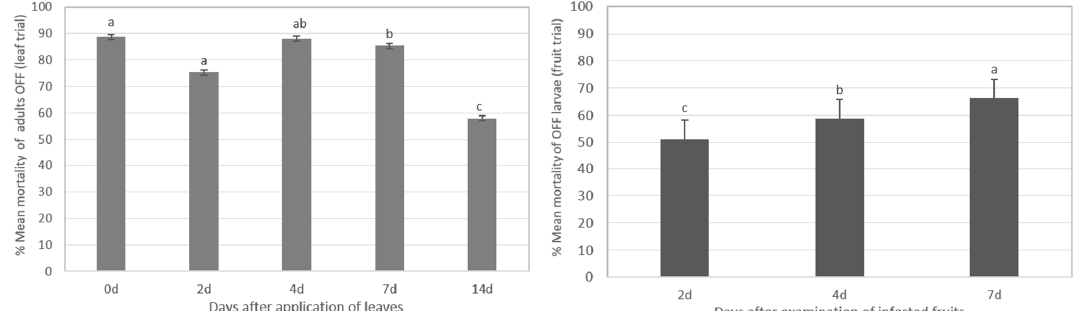
Figure 6. Mean ± SE recorded mortality of olive fruit fly adults ( left ) and larval stages ( right ) versus time. Records of mortality with the same letter are not significantly different at p < 0.05.